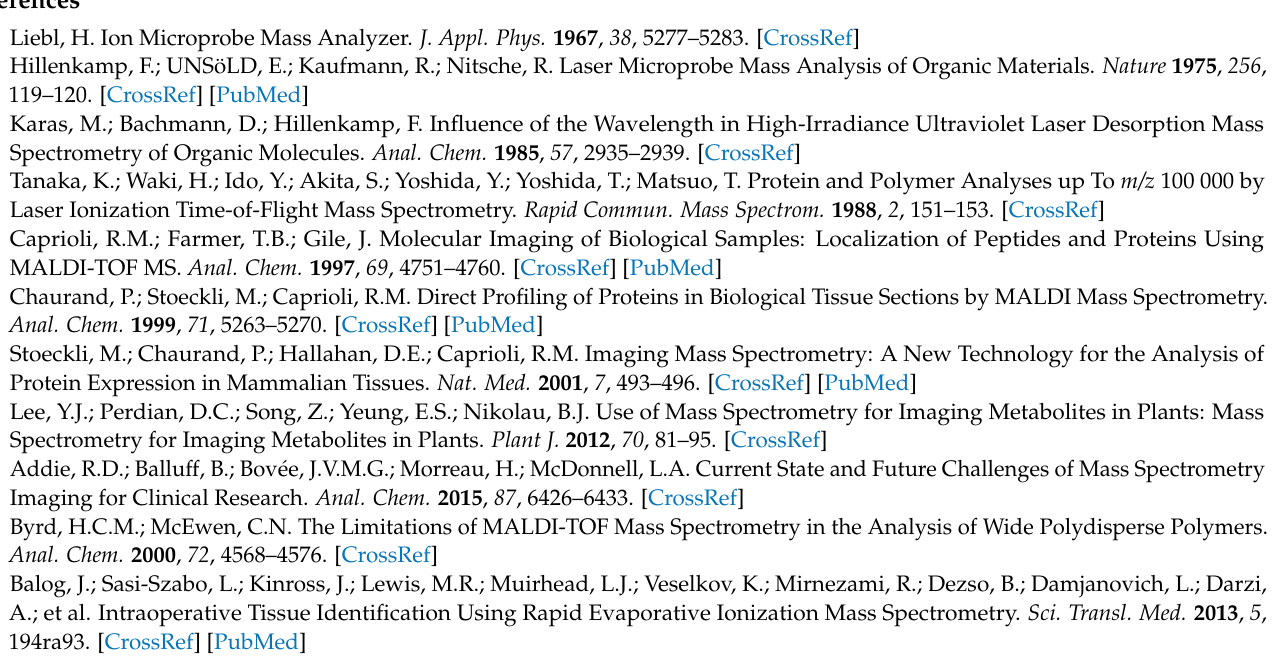
P25 sample. Figure S4. ζ potential vs. pH of P25 aqueous slurry. Figure S5. MALDI/TOF full mass spectrum of a fingermark showing different fatty acids (probable structures, see Table S1 for identification) and different images created on six analytes. Table S1. Probable